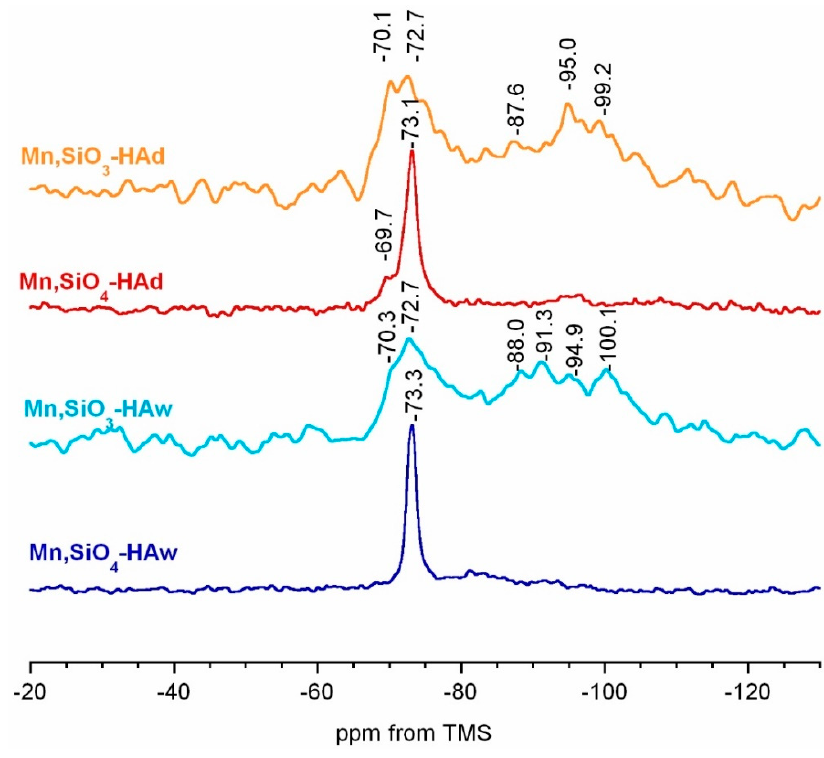
Figure 6. 29 Si CP MAS NMR spectra of the analyzed samples.